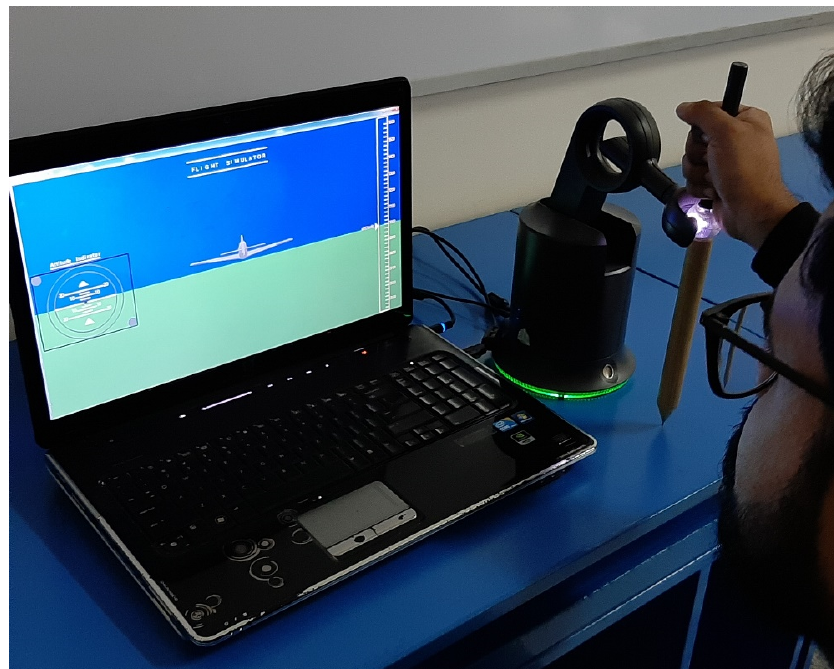
Figure 7. Experimental